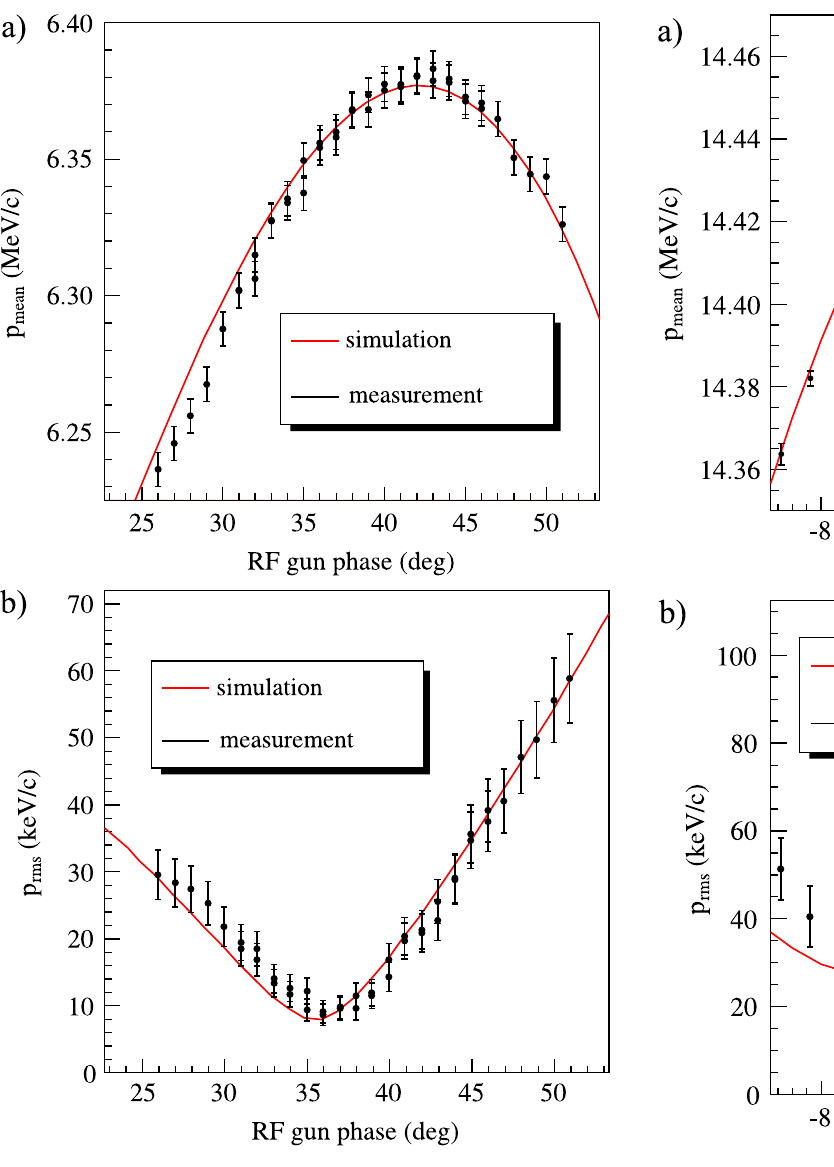
FIG. 24. (Color) Measured and simulated (a) mean momentum and (b) momentum spread of the electron beam from gun prototype 3.2 with increased peak field at the cathode.